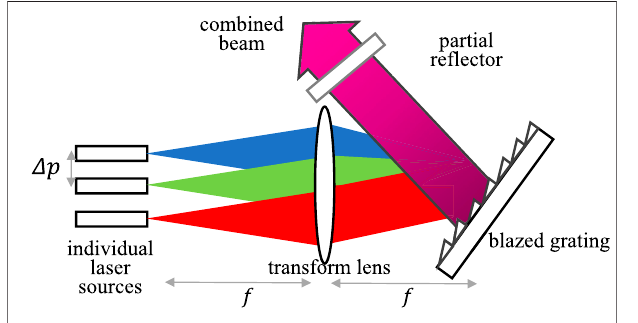
FIGURE 2 | Schematic diagram of the irradiated blazed